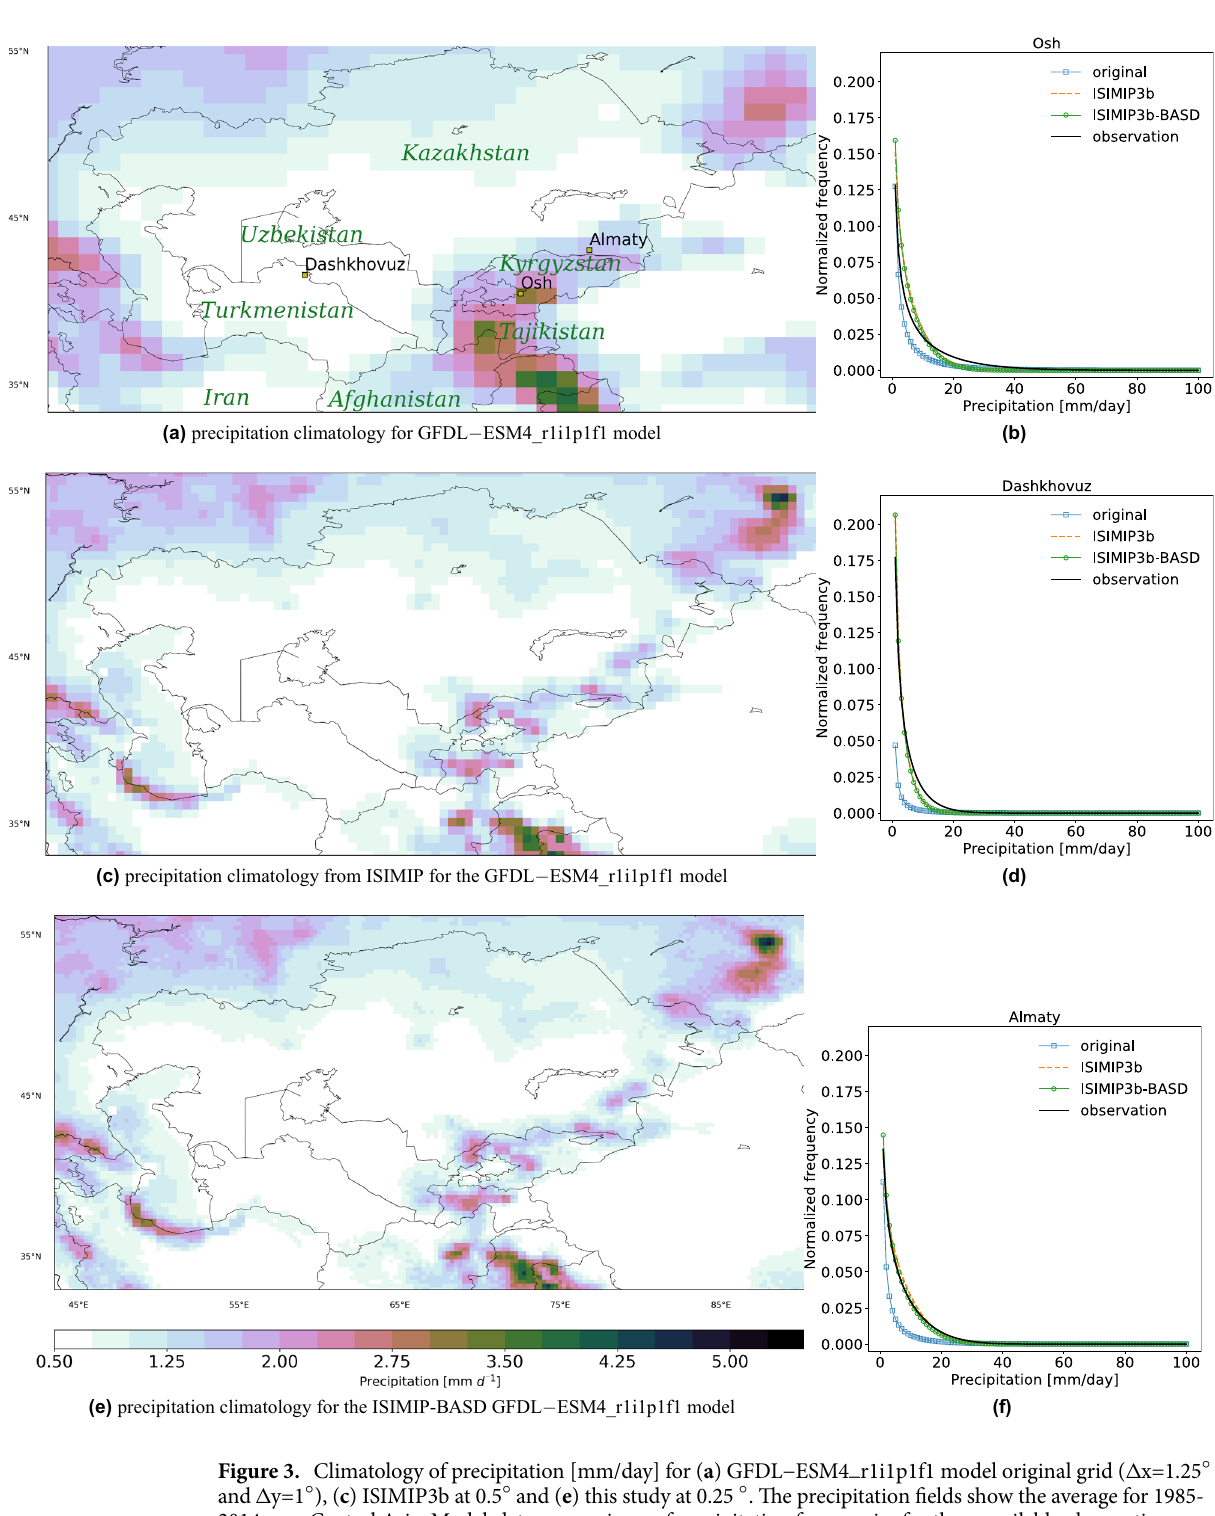
_ Figure 3. Climatology of precipitation [mm/day] for ( a ) GFDL−ESM4 r1i1p1f1 model original grid ( (cid:31) x=1.25 ◦ ◦ ◦ and (cid:31) y=1 ), ( c ) ISIMIP3b at 0.5 and ( e ) this study at 0.25 . The precipitation fields show the average for 1985- 2014 over Central Asia. Model-data comparison of precipitation frequencies for three available observations, shown in ( a ) for 1985–2000 ( b , d , f ). The maps were created using python3-matplotlib (version 3.1.2, https:// matpl otlib.